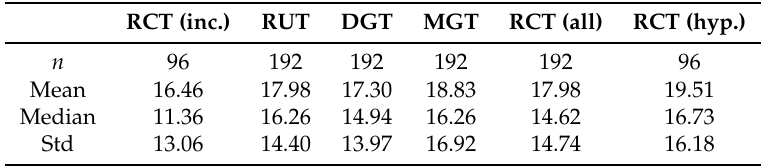
Table 1. Descriptive analysis on subjects’ SVO